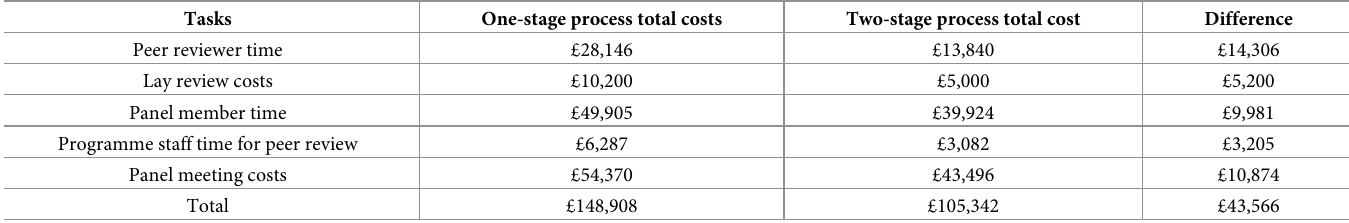
Table 4. Summary of cost differences between one-stage and two-stage